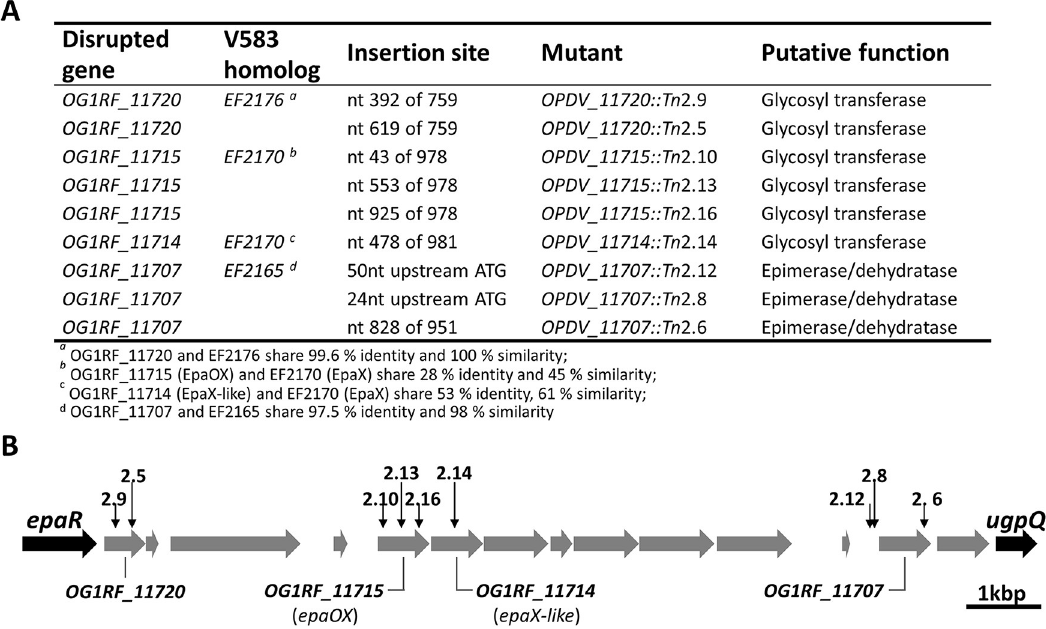
Fig 1. Identification of epa mutants resistant to lysozyme. A . Description of individual transposon insertions. B . Mapping of transposon insertions in the epa variable region. Insertion sites are indicated by vertical arrows. ORFs in the epa variable region are depicted in grey.